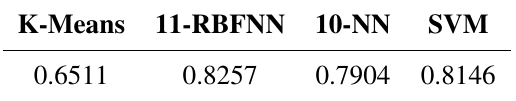
Table 10. Kappa values for the experiments with the best overall